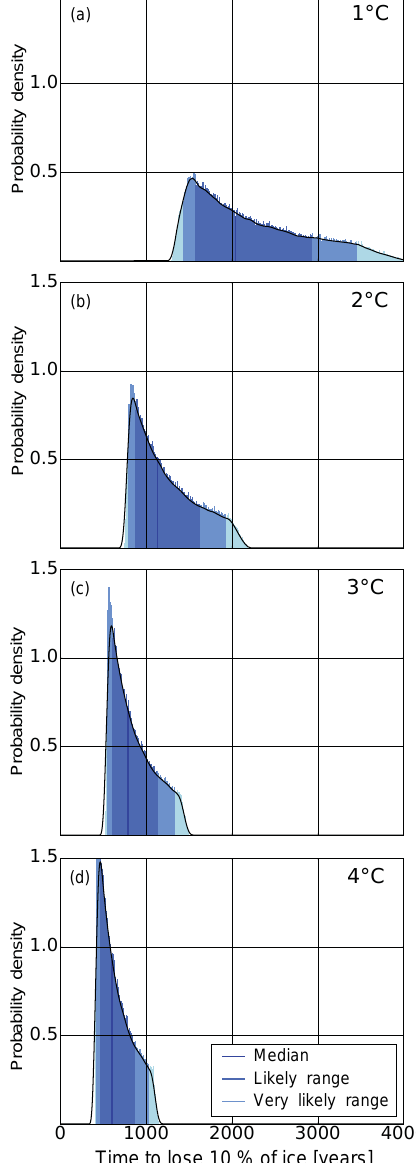
Figure 4. Likelihood for 10% decay of Greenland Ice Sheet. Shown are the probabilities for the ice sheet to lose 10% of its initial ice volume in a certain time period for surface warming of (a) + 1 ◦ C, (b) + 2 ◦ C, (c) + 3 ◦ C and (d) + 4 ◦ C above the threshold. The me- dian is indicated by the black line, and the likely and very likely ranges are shaded in dark and light blue respectively.